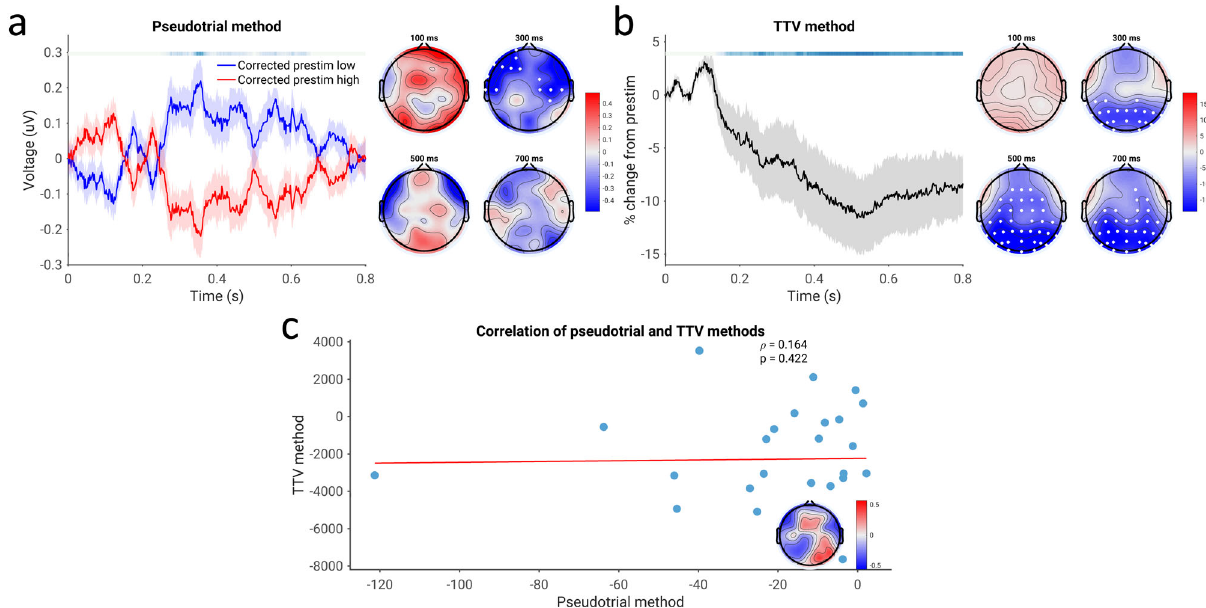
Fig. 7 Correlation of spontaneous and evoked EEG voltage for the replication EEG dataset (equivalent to Fig. 3 in the main dataset). a Pseudotrial- corrected time courses for high prestimulus (red) and low prestimulus (blue) conditions. Line shows mean across all sensors and subjects, shaded area indicates standard error of the channel-average time course across subjects. Effect topographies are shown at 100 ms, 300 ms, 500 ms, and 700 ms; white dots indicate sensors which are part of a signi fi cant cluster. Shaded overbars indicate the signi fi cance of the difference between prestim high and low conditions. The shade of the bar indicates the percent of sensors which are part of a signi fi cant cluster at any given time point (i.e., darkest = all sensors part of cluster, lightest/white = no sensors part of cluster); red indicates positive clusters (prestim high > prestim low), blue indicates negative clusters. b Time course of trial-to-trial variability. Lines, overbars, and topographies as in a): red overbars indicate clusters with TTV increases, blue overbars indicate TTV decreases. c Correlation of the two methods. Mean values of the summary indices across sensors are plotted in the scatterplot, and the correlation coef fi cient at each electrode is plotted in the inset. White dots indicate sensors signi fi cant after cluster correction. N = 22